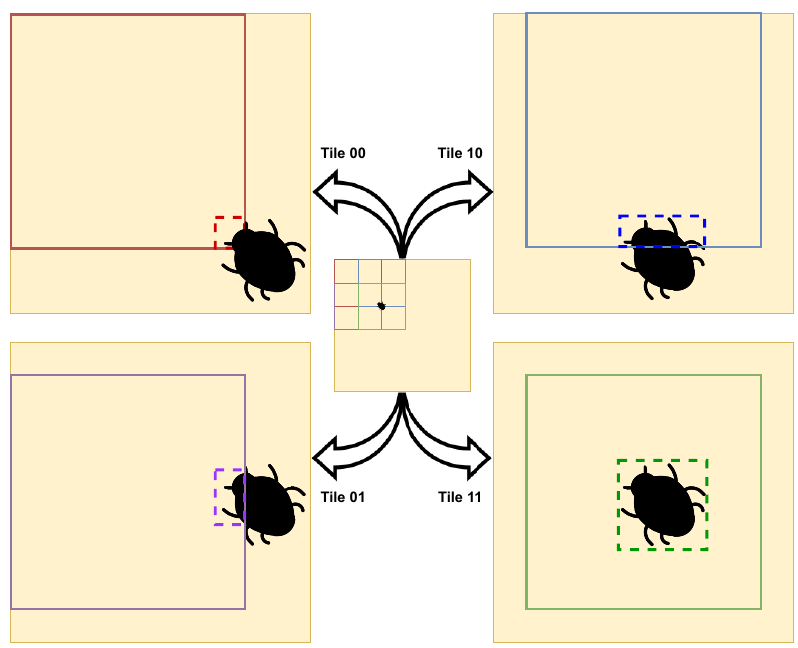
Figure 5. Illustration of overlapping tiles that split insects. Tables 5 and 6 also reflect that ODS and OSS approaches achieve similar results with the YOLOv5x model, reaching the best results in both cases. However, due to the uniformity that OSS provides to the dimensions of the tiles without the need for resizing, the OSS approach was considered for the development of the remaining work. Table 5. YOLOv5 insect model results for ODS.